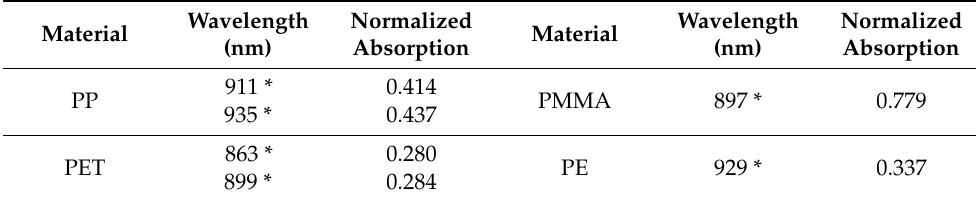
Table 1. Representative peak wavelengths for polymers used in this